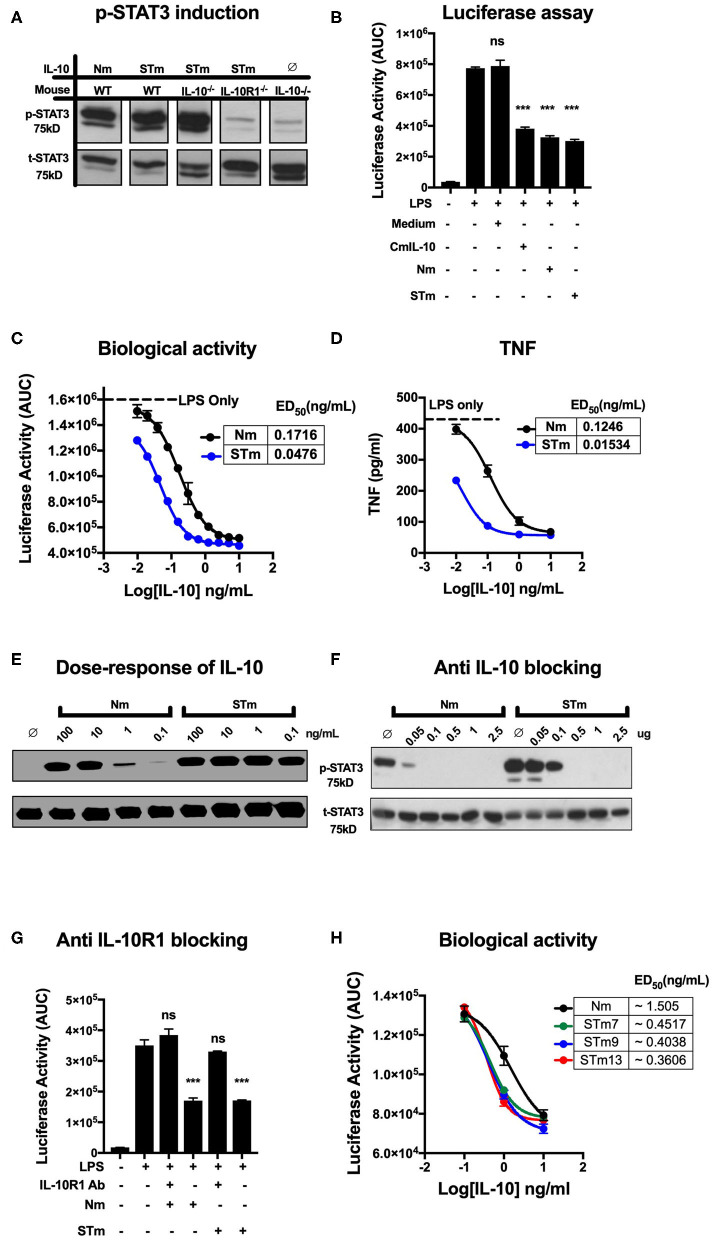
Stable mouse IL-10 (STm) is biologically active in vitro. (A) Specific induction of STAT3 phosphorylation by STm (5 ng/mL) was verified by the use of spleen cells from different mouse lines: Wild type C57BL/6 (WT), IL-10 knockout (IL-10−/−) and IL-10 receptor knockout (IL-10R1−/−). (B) Luciferase activity was monitored as the area under the curve (AUC) from BMDMs reporter mouse; cells were either unstimulated or stimulated with LPS (10 ng/mL) in the presence or absence of IL-10 from HEK293 EBNA supernatants. A commercial mouse IL-10 (CmIL-10) was used as a positive control, and un-transfected cells supernatants (Medium) served as a negative control. Significant difference considered by comparing to LPS stimulated cells as follows: not significant (ns), ***p < 0.001; ANOVA. (C) The dose-response effect of IL-10 on LPS-treated BMDMs of the transgenic mouse: the ED50 of Nm (black line) and STm (blue line) was calculated as 0.17 and 0.04 ng/mL, respectively. The maximum luciferase induction was determined by treating the BMDMs of the transgenic mouse with LPS alone at 10 ng/mL as it showed a black dot line. (D) Soluble mouse TNF was measured from the medium 24 h from BMDMs of the transgenic mouse either after LPS stimulation alone or after co-treating with either Nm (black line) or STm (blue line) in a dose-dependent fashion. (E) Splenocyte lysates of the C57BL/6 mouse were either unstimulated (∅) or stimulated with IL-10 (Natural type or Stable) in a dose-dependent manner. (F) Inhibition of Nm and STm induced STAT3 phosphorylation by a blocking IL-10 antibody (clone JES5-2A5). IL 10 (2.5 ng) was mixed with the indicated amounts of antibody in one volume of 25 μl of medium and preincubated on ice for 30 min before adding this batch to 475 μl of spleen cell suspension. (G) The Luciferase activity represented as AUC from LPS-induce cells from transgenic mouse were either unstimulated or treated with 0.2 μg/mL of the antiIL-10 receptor (antiIL-10Ra) antibody (clone 1B1.3a) for 30 min at 37°C before treatment with LPS (10 ng/mL) or LPS (10 ng/mL), Nm (10 ng/mL), or STm (10 ng/mL). Furthermore, a significant difference is also calculated to compered Nm with STm after antiIL-10Ra treatment; ANOVA. (H) The dose-response stable IL-10 on LPS-treated BMDMs of transgenic mouse: the ED50 of Nm (black line) is 1.5 ng/mL and the ED50 of STm proteins: STm7 (green) STm9 (blue line) and STm13 (red line) is calculated as 0.45 ng/mL and 0.40 and 0.38 ng/mL respectively. All data are representative of three independent experiments, with triplicate cultures per experiment (N = 3, n = 3), and bars represent standard error of the mean.